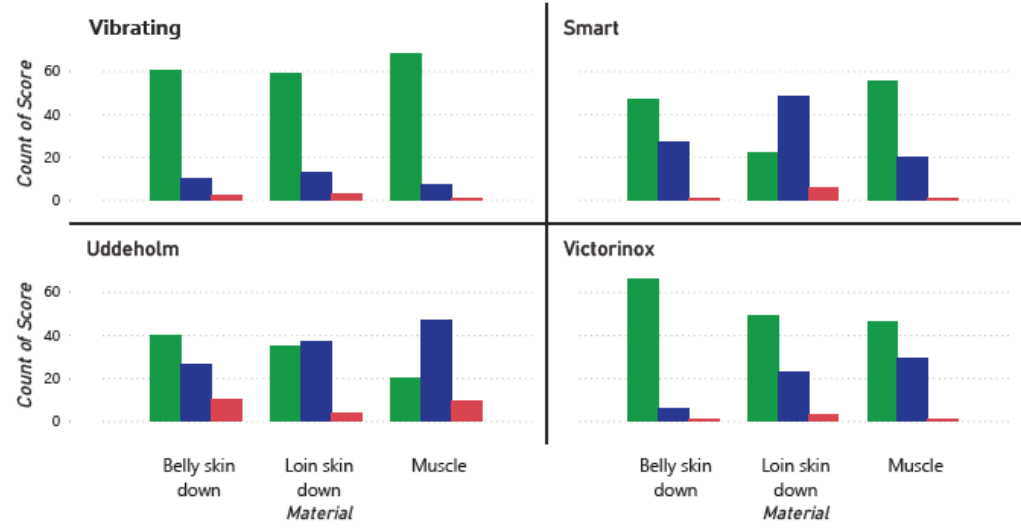
Fig. 3. Respondents’ scores on cutting quality of different knives (frames) on various pork samples (horizontal axis). Score 1 = flawless 2 = minor flaws, but acceptable for further use and processing; 3 =